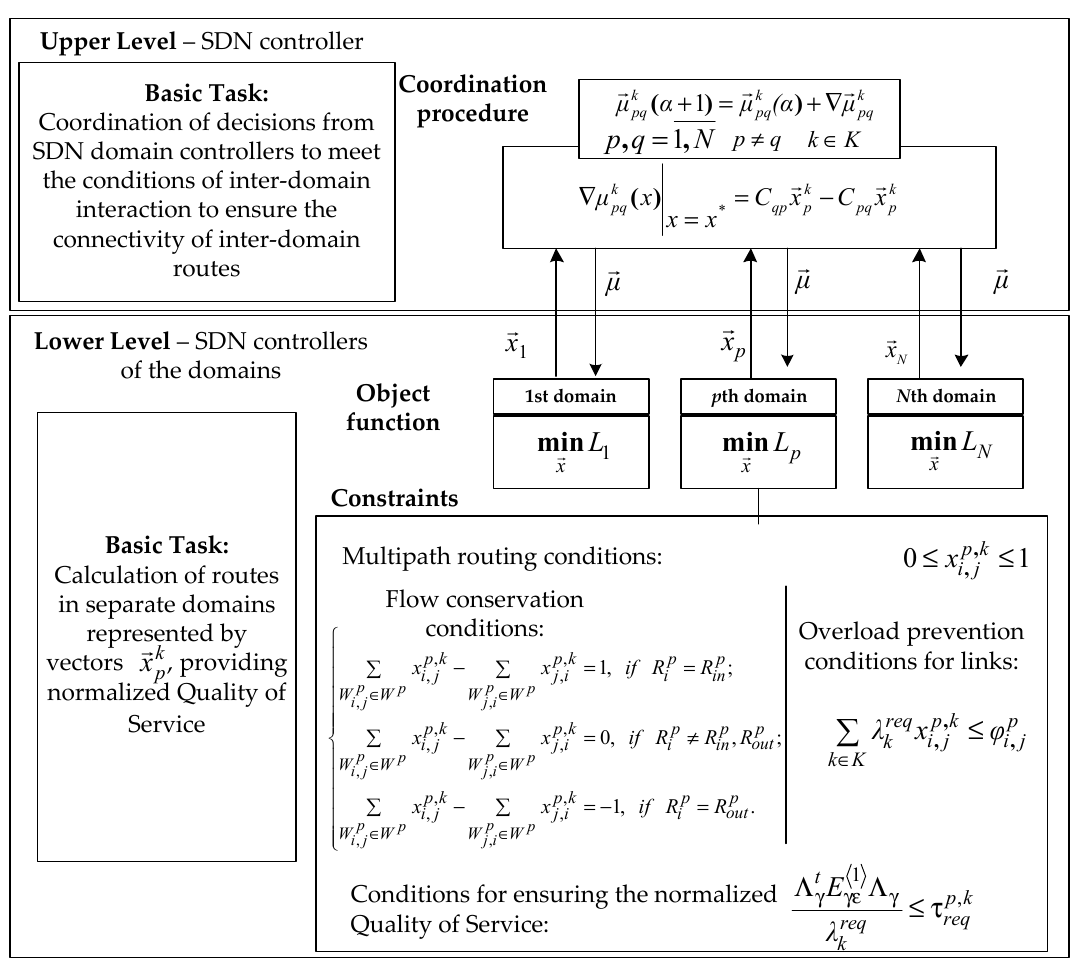
Figure 4. Two-level method architecture.